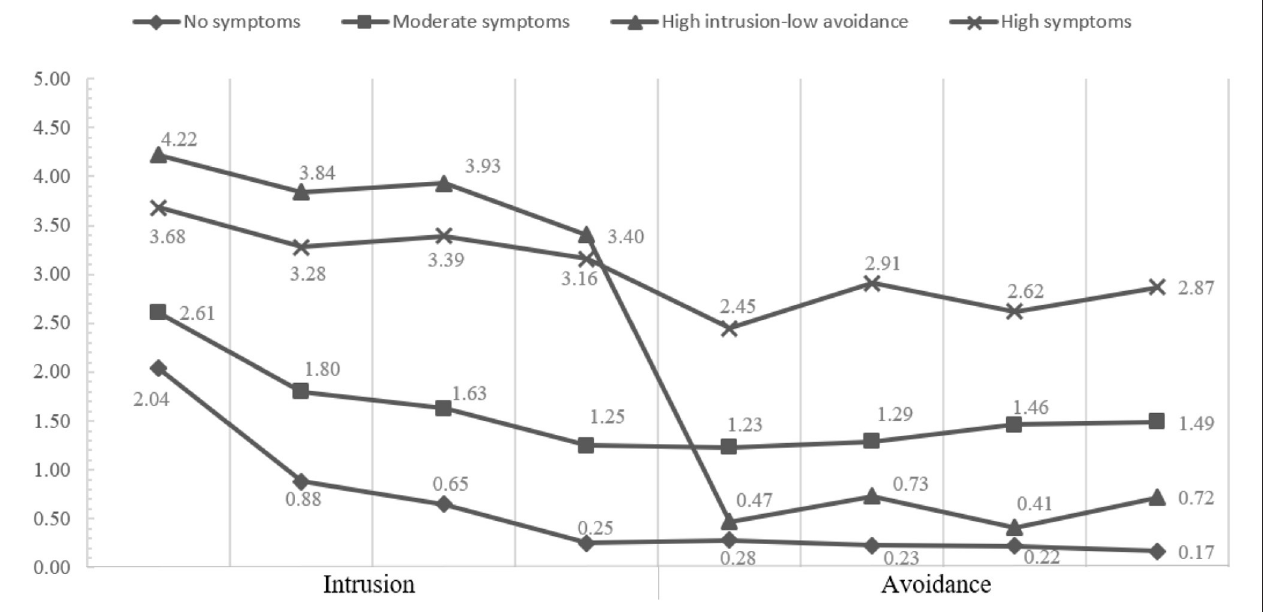
FIGURE 1 | Standardized means of intrusion and avoidance across four profiles ( N =